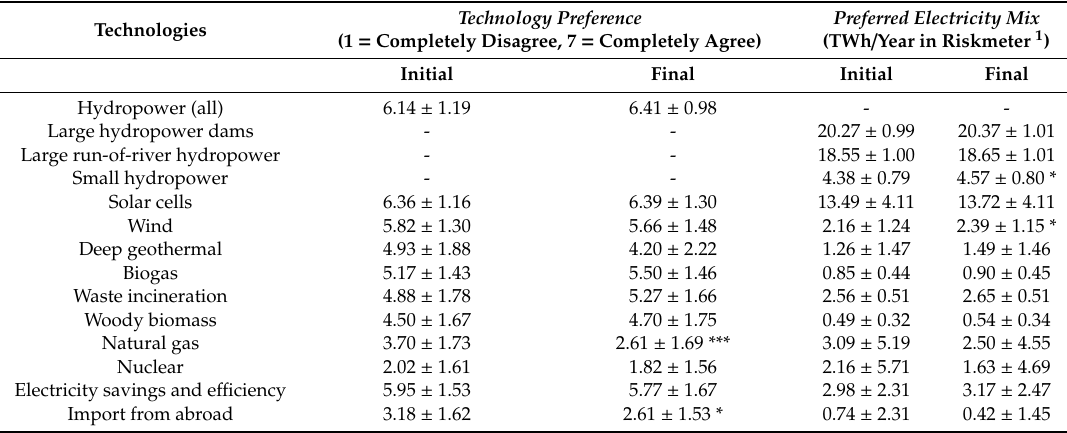
Table 1. Initial and final technology preferences and preferred electricity mixes (means ± standard deviations) for Switzerland for